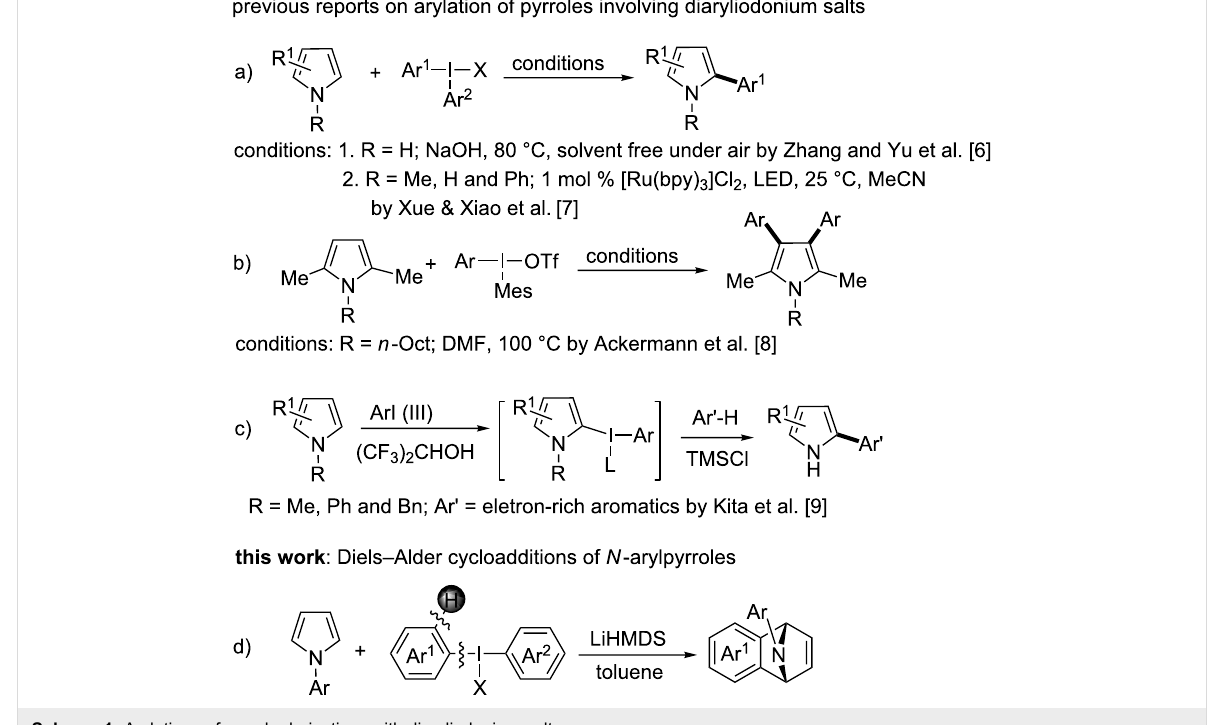
Scheme 1: Arylations of pyrrole derivatives with diaryliodonium